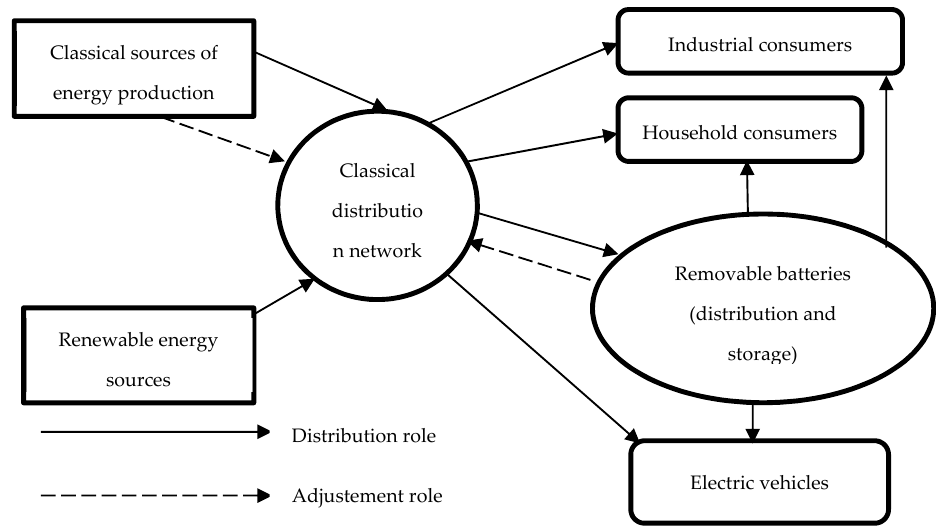
Figure 1. Integrated electricity storage and supply system. Source: developed by authors.